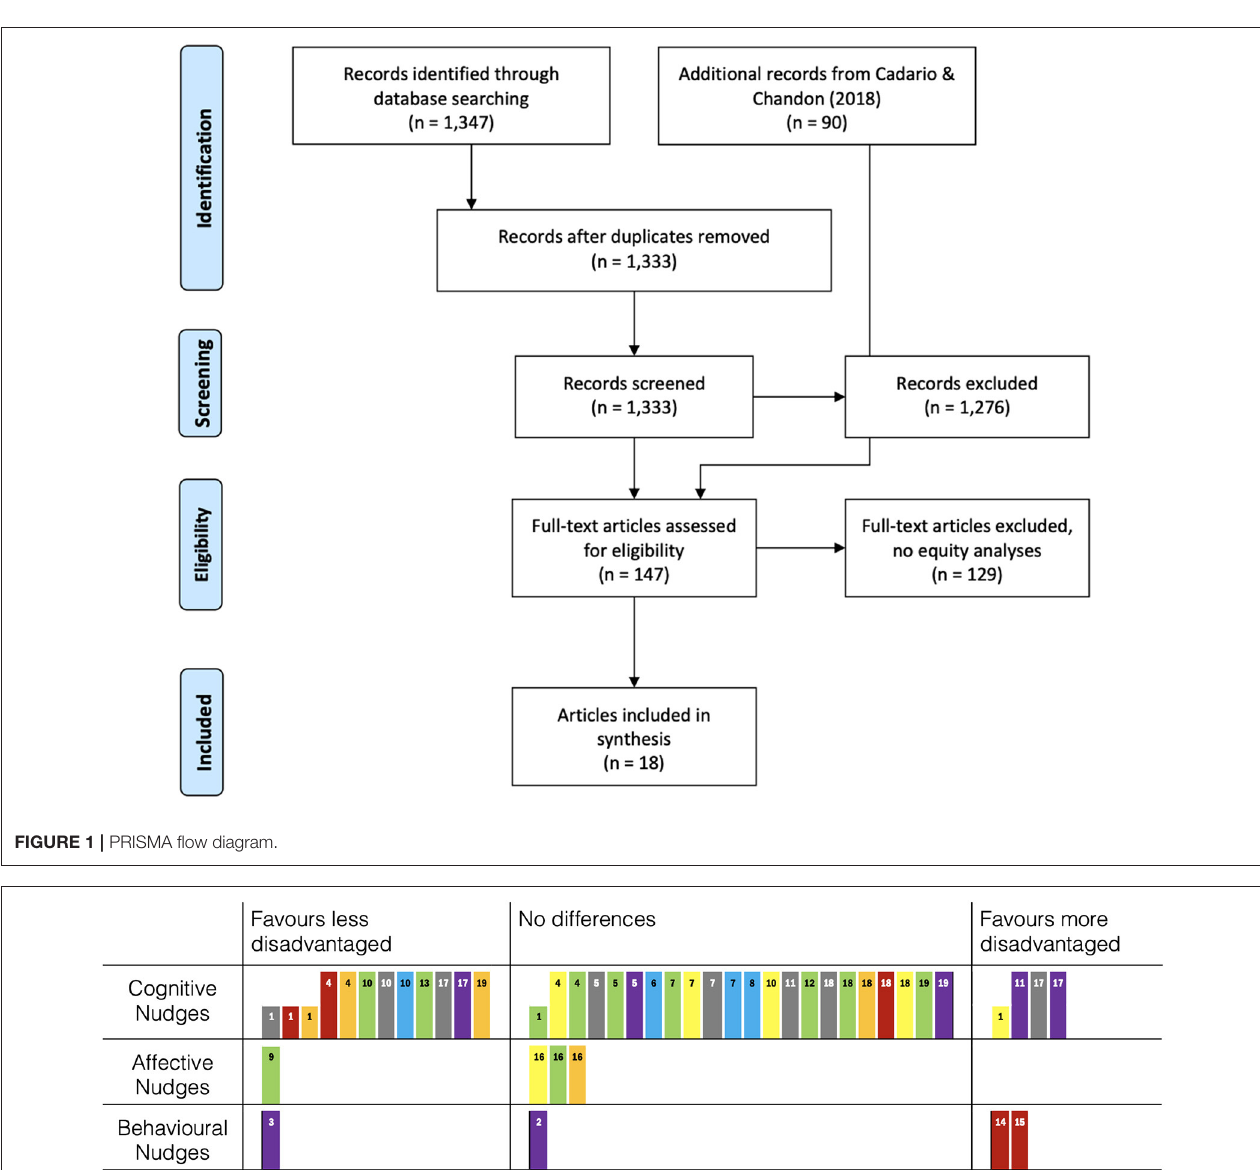
FIGURE 2 | Harvest Plot: Equity comparisons of dietary nudges. Column height represents dietary assessment (low = self-report, high = objective). Numbers in columns refer to study number in Table 1 .